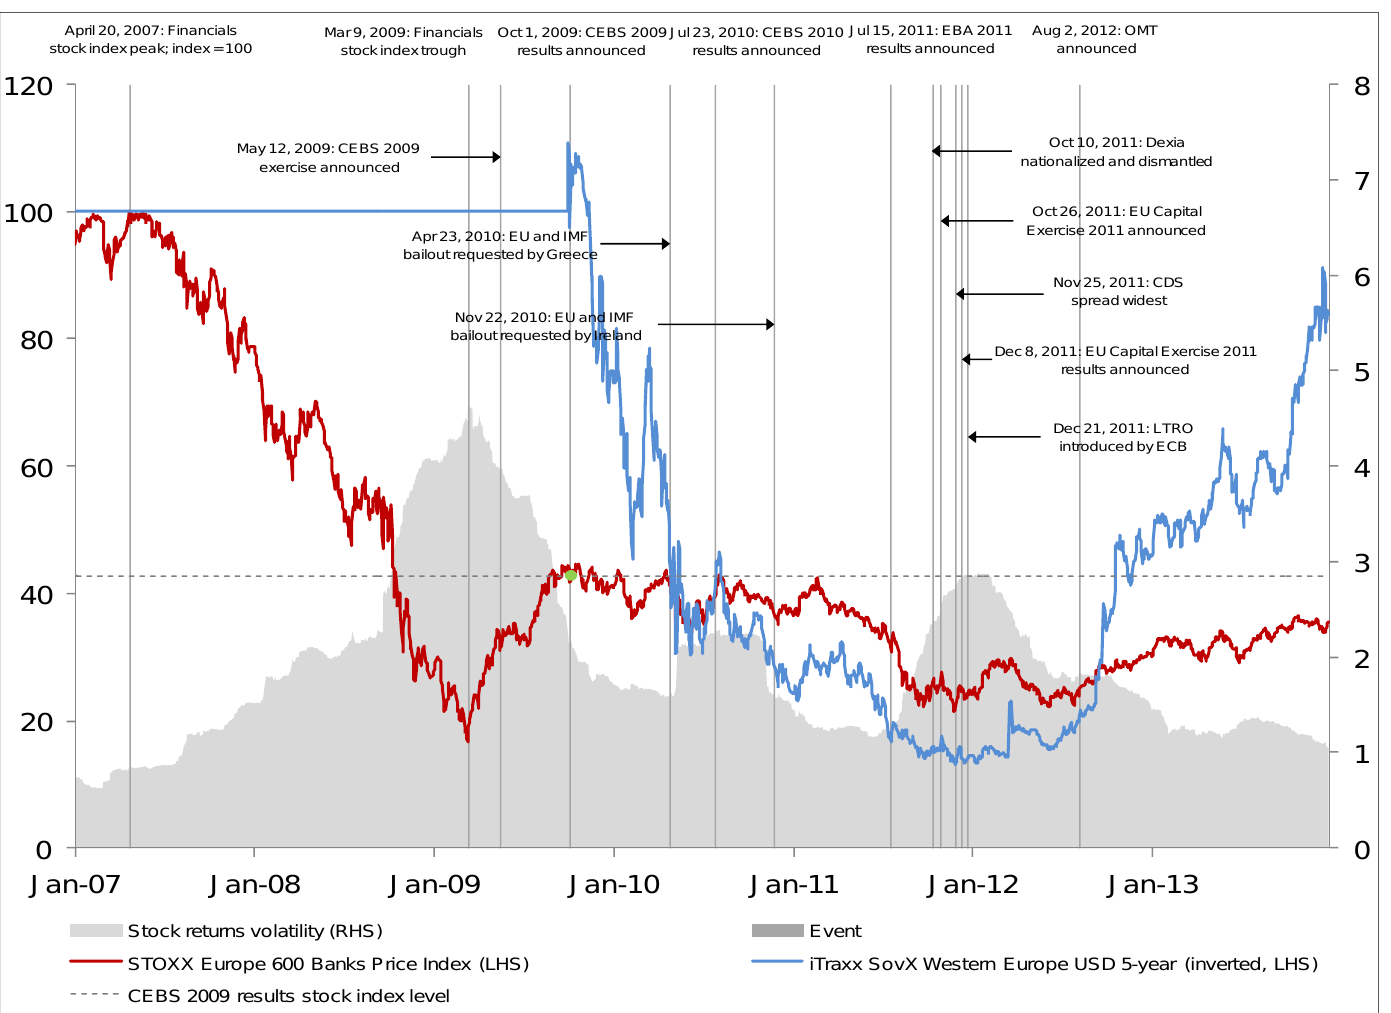
Figure 3. European Union: The Ebb from the EBA (Indexed to 100 on 20 April